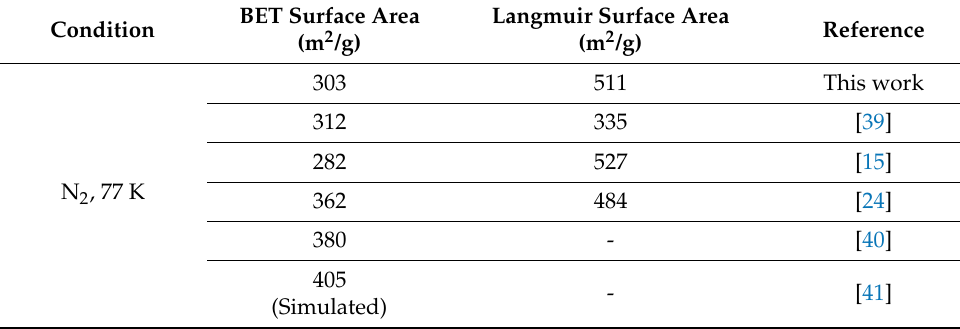
Figure 5. N 2 and CO 2 adsorption/desorption isotherms of the synthesized ZIF ‐ 7 at 293K. Table 1. BET and Langmuir surface area of ZIF ‐ 7 with references.